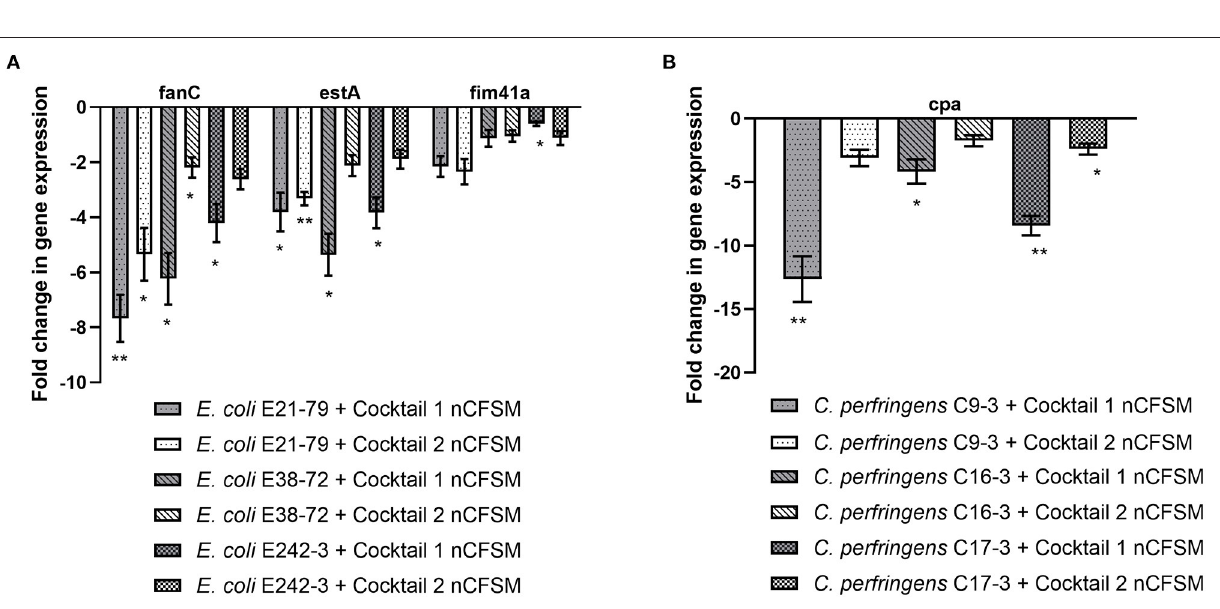
FIGURE 6 | Effect of nCFSM from two cocktails of LAB strains on expression of fanC, estA and fim41a in 3 E. coli strains (A) , and cpa in 3 C. perfringens strains (B), and the data are presented as fold change of expression levels in nCFSM relative to non-fermented milk. The expression data of virulence genes for E. coli were normalized to gapA and nusG, and C. perfringens were normalized to 16sRNA and GAPDH . Three independent replicates including two technical replicates each were performed. The data shown represents the mean and the error bars represent standard deviations. The stars indicate statistical significance at different levels: * P ≤ 0.05, ** P ≤